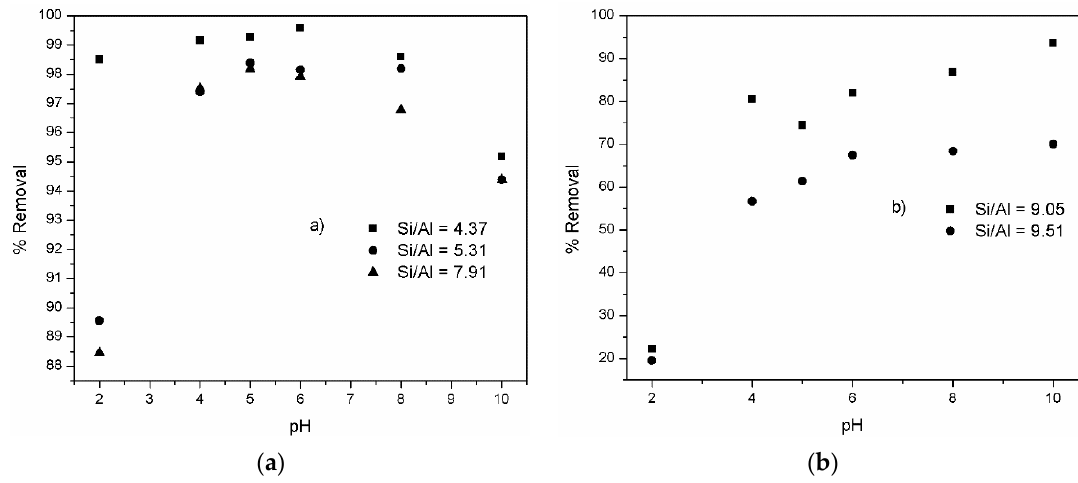
Figure 10. Effect of solution pH on Pb(II) sorption by samples with ( a ) Si/Al = 4.37, 5.31, and 7.91 and Figure 10. E ff ect of solution pH on Pb(II) sorption by samples with ( a ) Si / Al = 4.37, 5.31, and 7.91 and ( b ) Si/Al = 9.05 and 9.51. ( b ) Si / Al = 9.05 and